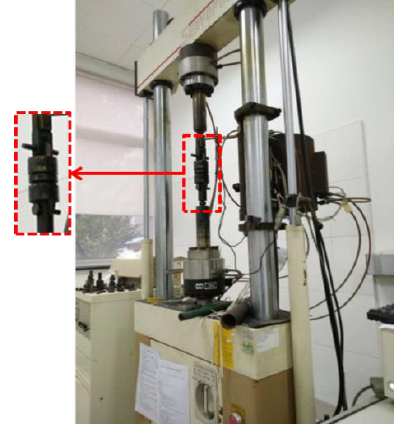
Figure 5. The installation of the fixture device for the fatigue test.